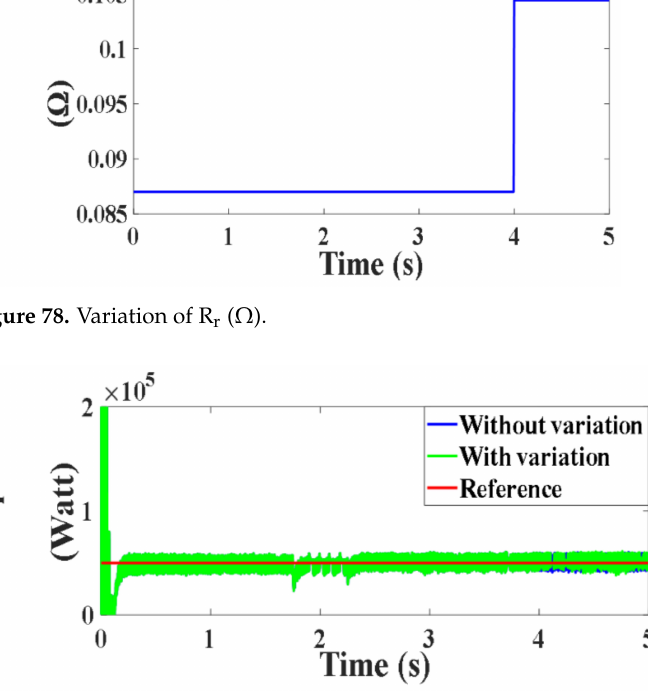
Figure 79. Active power under PVC (Watt).